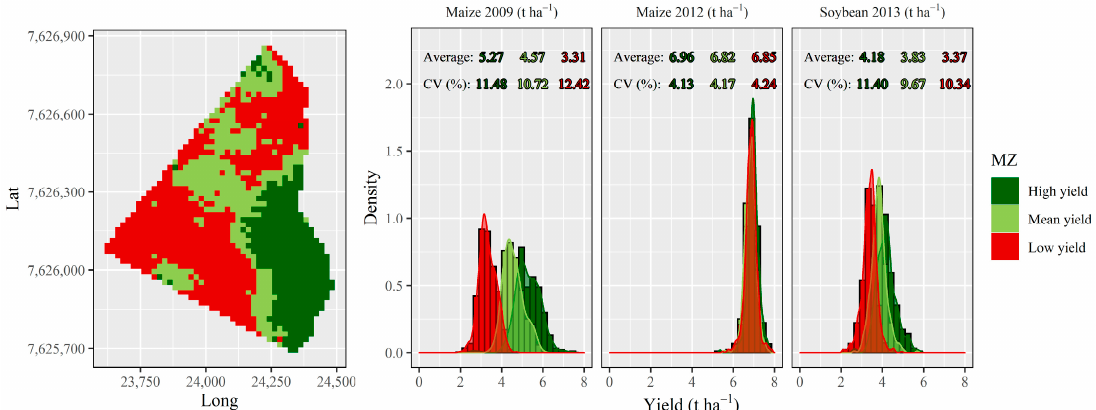
Figure 5. Management zones based on the K-means clustering algorithm.